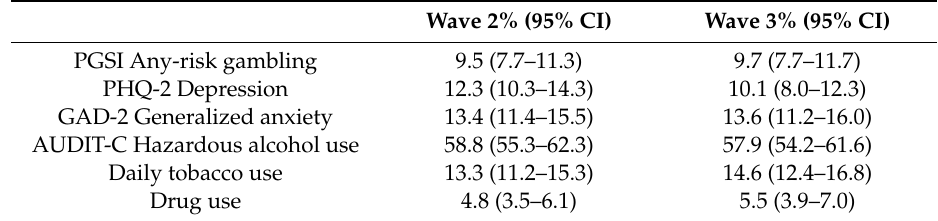
Table 1. Pooled proportions and their 95% confidence intervals (CI)